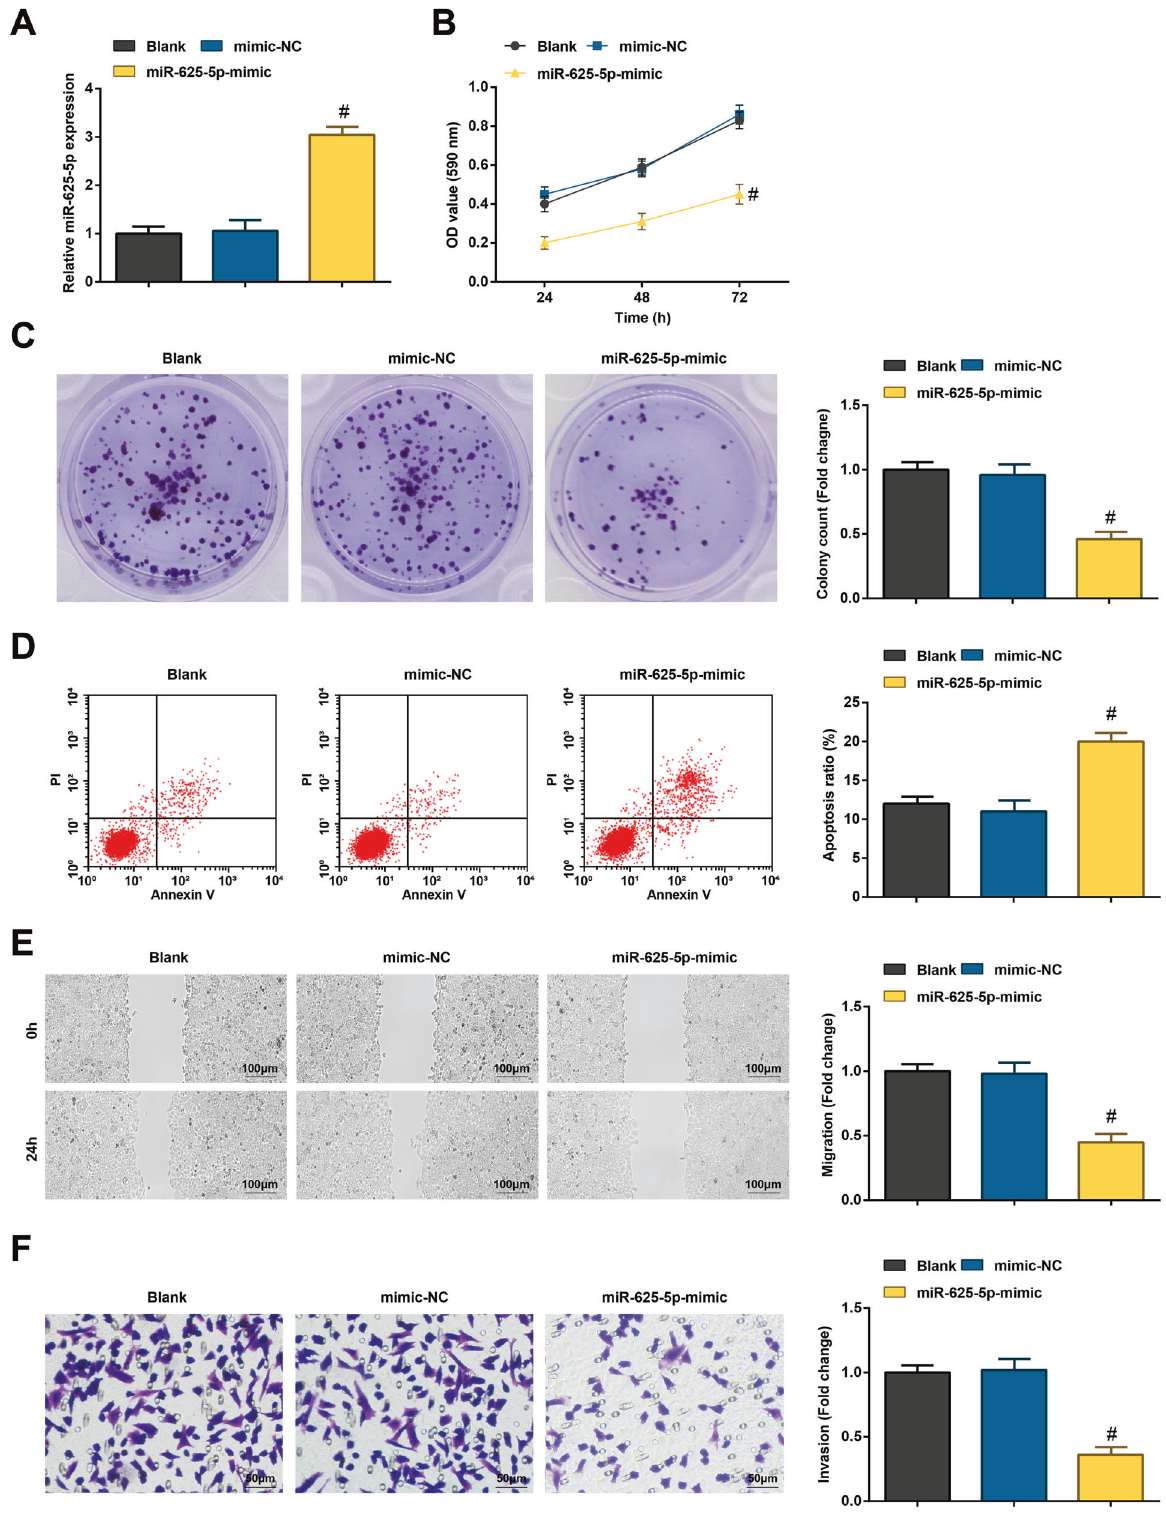
Fig. 5 Restored miR-625-5p destroys CC cell viability and colony forming ability and encourages apoptosis. A RT-qPCR detected miR-625- 5p expression in CC cells; B MTT assay detected viability of CC cells; C colony formation assay detected colony-forming ability of CC cells; D fl ow cytometry detected apoptosis rate of CC cells; E scratch test detected migration ability of CC cells; F Transwell assay detected invasion ability of CC cells; the measurement data are expressed as mean ± standard deviation. N = 3. # P < 0.05 compared with the mimic-NC